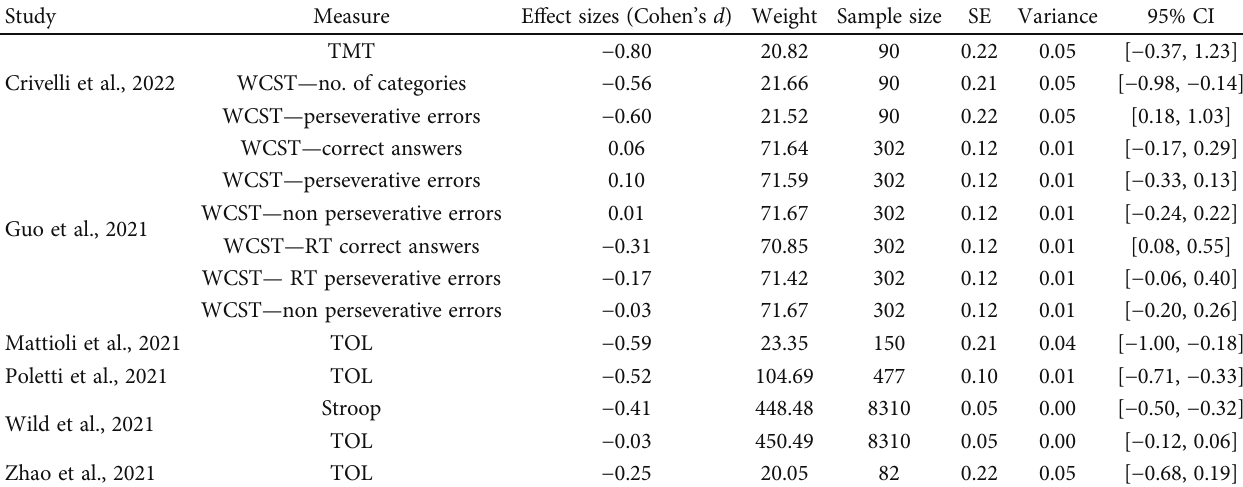
Table 3: E ff ect sizes from the selected studies tests and/or